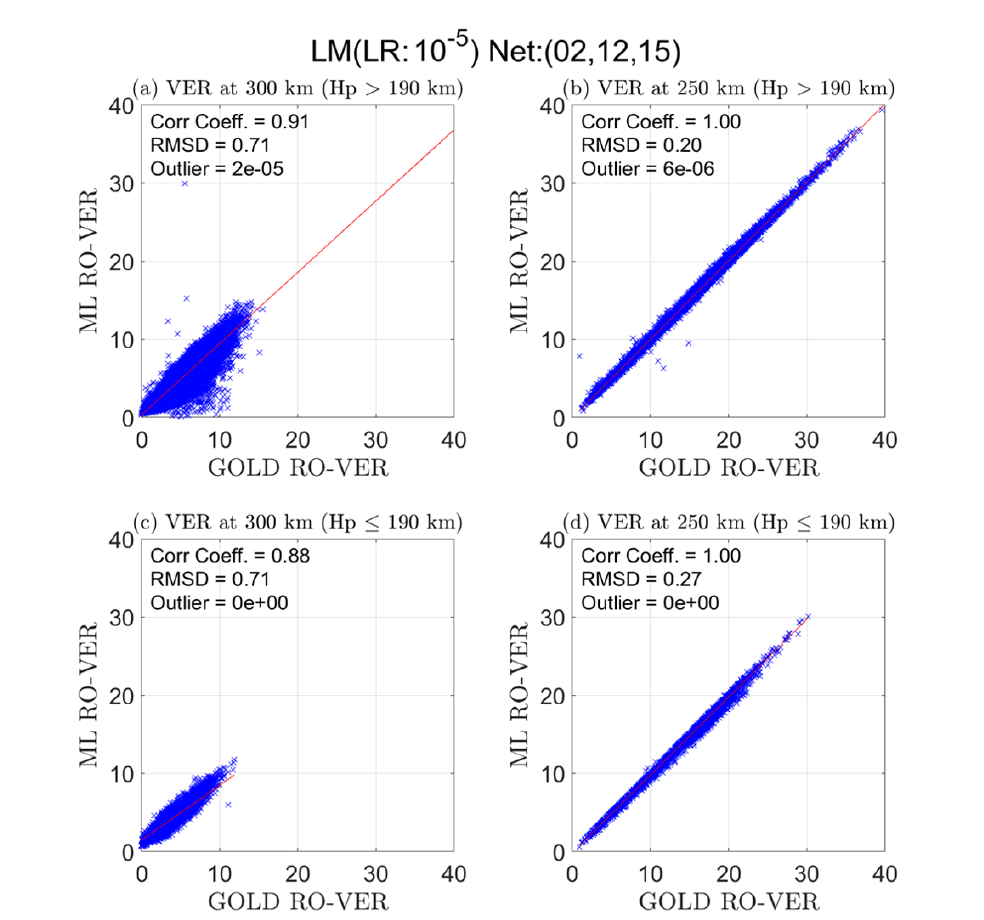
Figure 10. Similar to Figures 8 and 9, but the hidden layers set as (02, 12, 15) and trained with the algorithm LM.